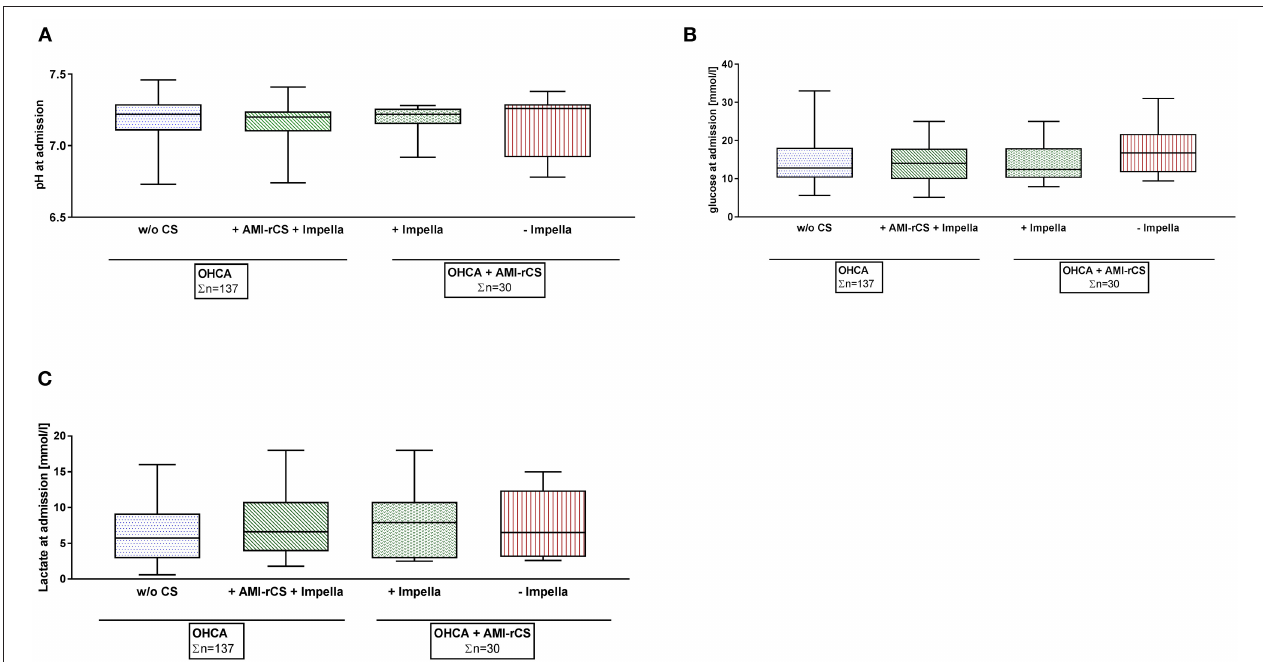
FIGURE 2 | Baseline blood gas analysis of propensity score-matched cohorts. AMI, acute myocardial infarction; CS, cardiogenic shock; OHCA, out-of-hospital cardiac arrest; w/o, without; rCS, refractory cardiogenic shock. (A) pH at admission. (B) Glucose at admission. (C) Lactate at admission.